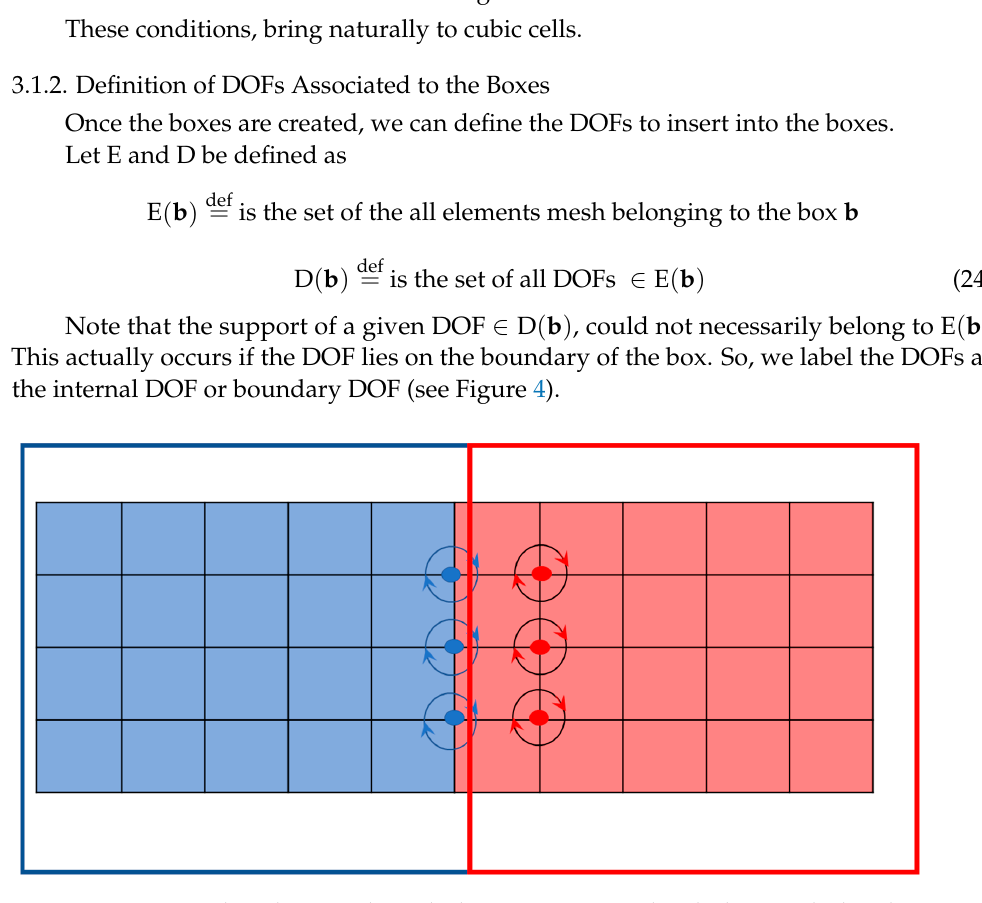
Figure 4. ELEMENT-based approach. Each element is associated to the box in which its barycenter lies. The two boxes element are marked blue and red, respectively. The blue DOFs are boundary DOF the red one are internal.